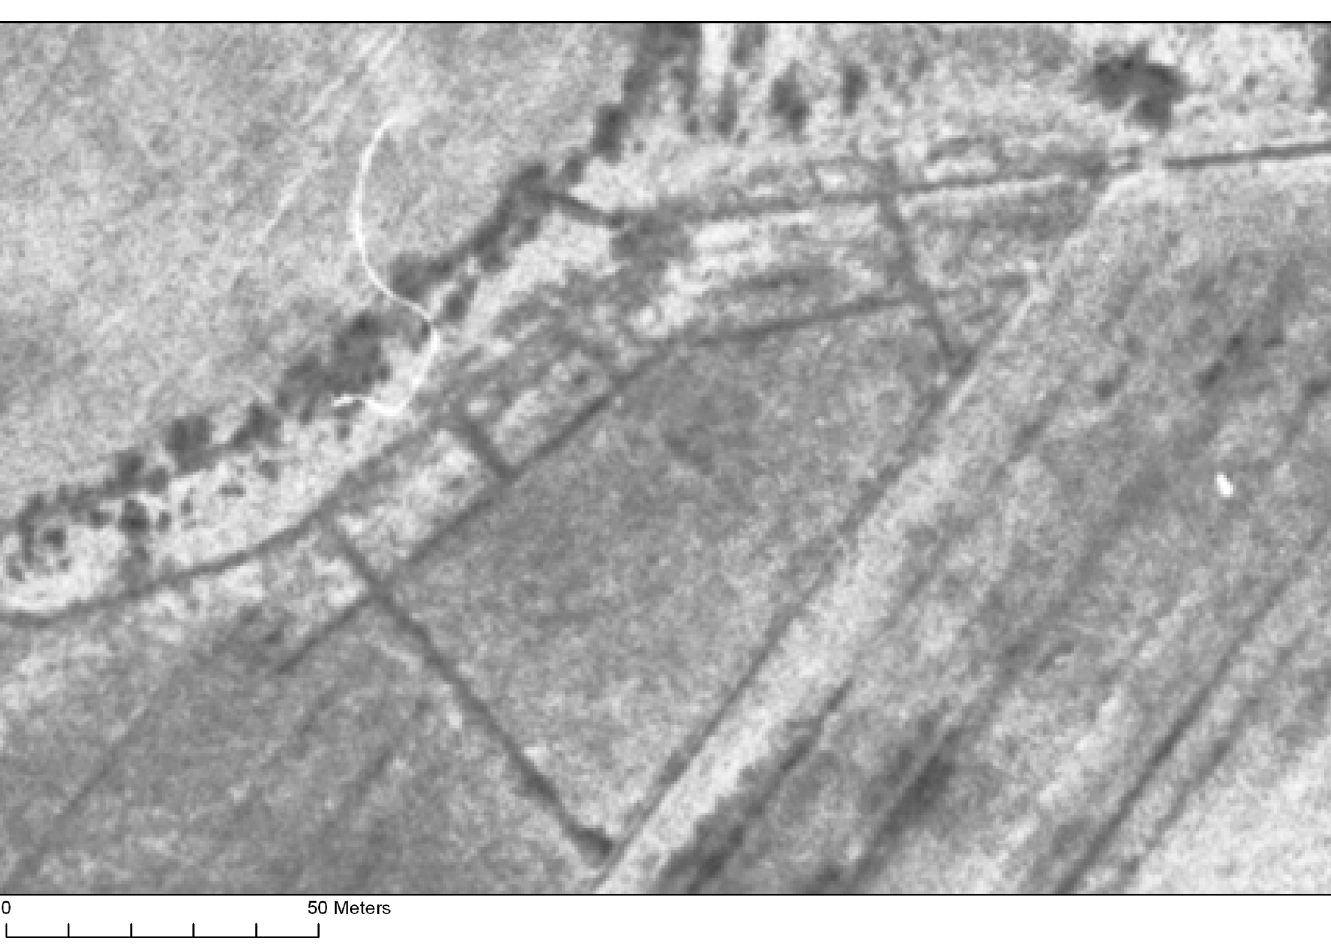
Fig 2. Aerial photography from 1957 (freely available from Lantma¨teriet through CC by 0 license) showing the original trenches from the 1940s.